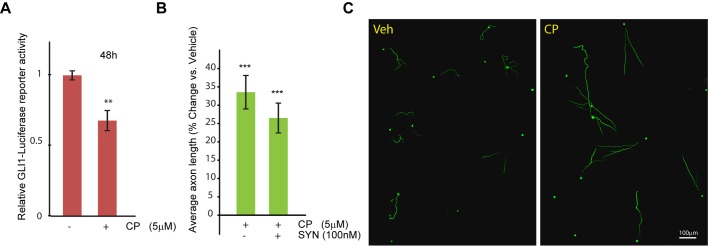
Cyclopamine inhibits GLI1 transcription and increases average axon length in cortical neurons. (A) Mouse cortical neurons were co-electroporated with GLI1 luciferase-based reporter and β-galactosidase expressing plasmids (1 µg pTF-GLI1-Luc-reporter and 0.2 µg EF1aLacZ per 1×106 cells). After plating for 24 h, DIV1 transfected neurons were treated with either cyclopamine (CP, 5 µM) or vehicle, and luciferase activity was evaluated. In B, DIV1 cortical neurons were treated with cyclopamine (CP), synaptamide or vehicle for 48 h, as indicated. Results are plotted as percent change in average axon length from vehicle-treated sample. At least, 714 cells were analyzed across all the replicates per point. (D) Representative images of the SMI-312-stained neurons treated with vehicle or cyclopamine (5 µM). In A and B data represents the average of at least three independent experiments performed in triplicates, error bars are ±s.e.m. Statistical significance was calculated using one-way ANOVA (A, P=0.002; B, P=2.28×10−11) followed by Tukey–Kramer post hoc tests; ***P<0.001 vs vehicle.